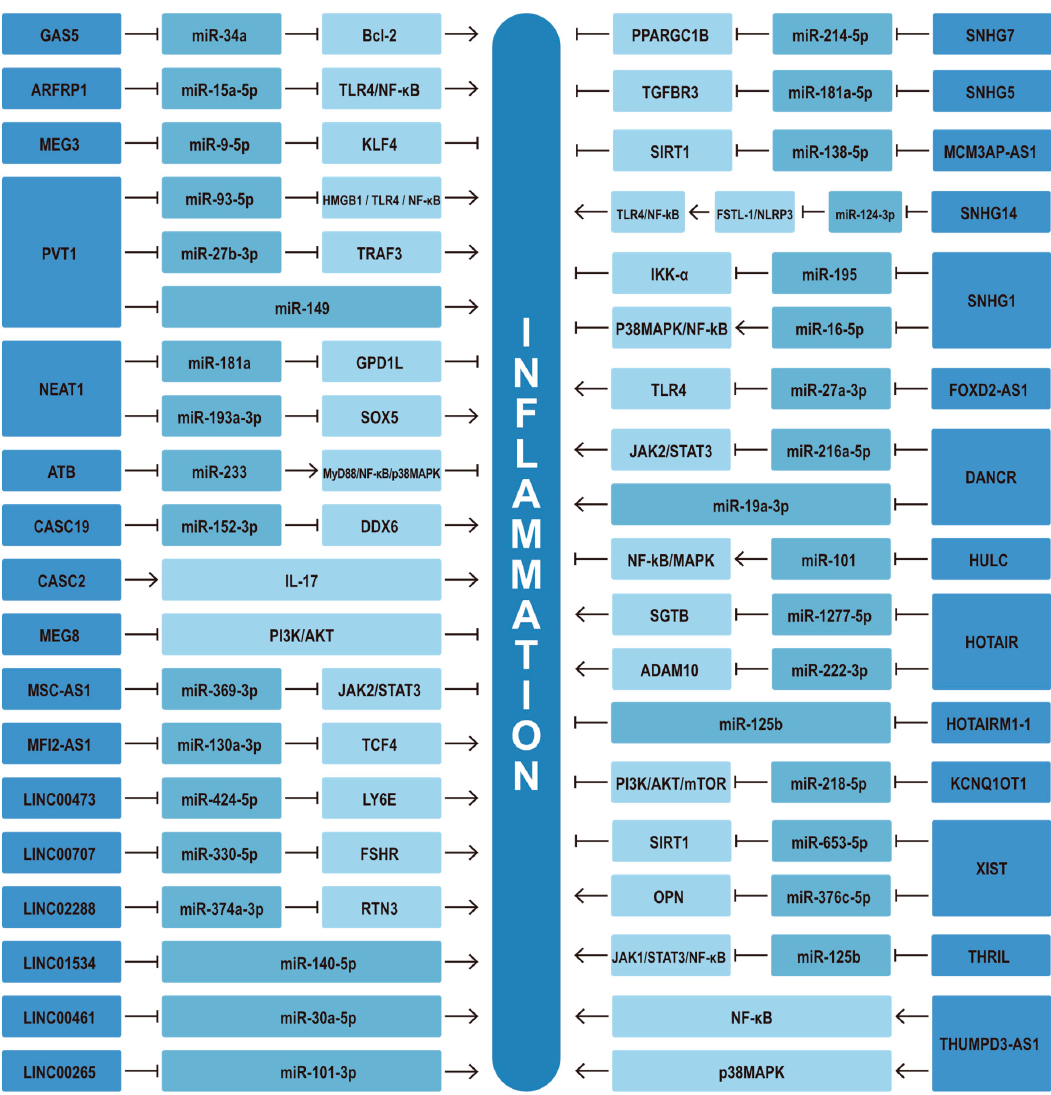
Figure 3. Schematic representation of the signaling pathways involved in this review for the regulation of inflammatory responses by lncRNAs. Different shades of color represent different molecules. Small nucleolar RNA host gene family (SNHG) has also become a kind of hot topic